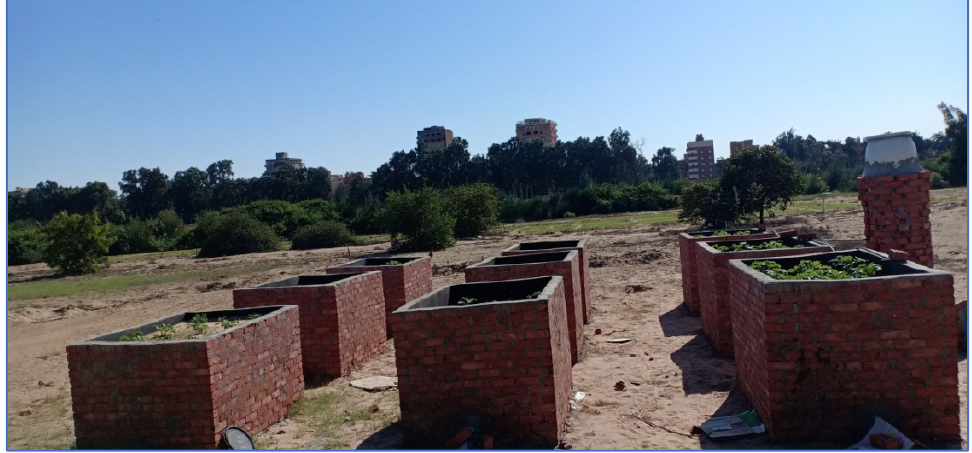
Figure 2. Nine experimental lysimeters, each 1.5 m long, 1.0 m wide, and 1.0 m high.